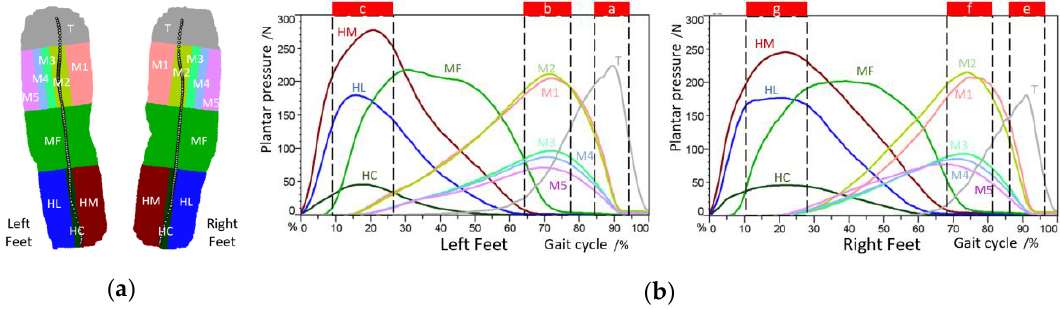
Figure 2. ( a ) Plantar pressure distribution; ( b ) Pressure curve of various regions of the sole.